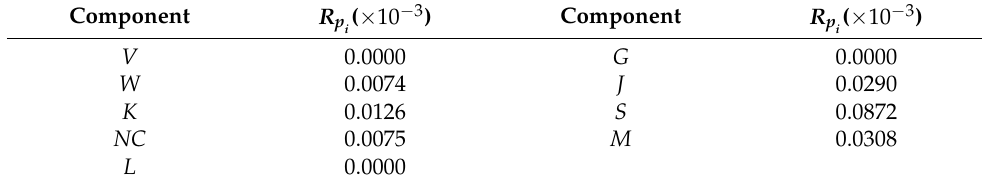
Table 13. Propagation failure risk value of each component of the machining center at 4000